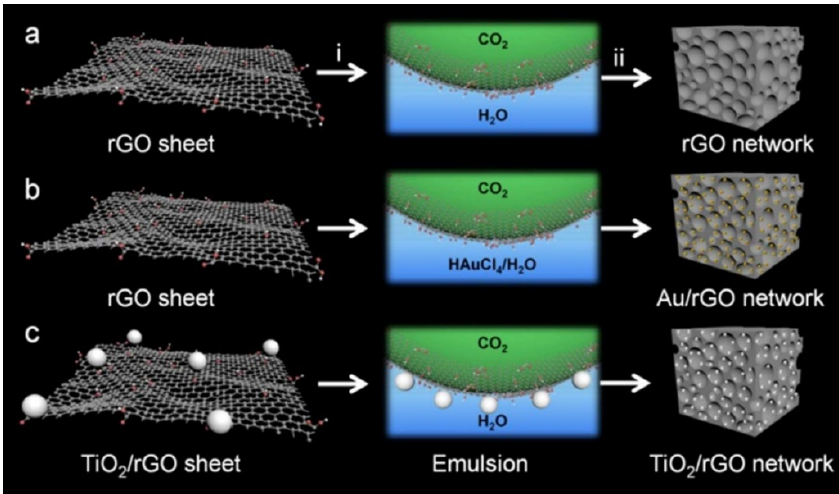
Figure 7. Schematic illustration for ( i ) forming emulsions in CO 2 and water with the aid of rGO or rGO hybrid and ( ii ) constructing rGO network ( a ), Au/rGO network ( b ) and TiO 2 /rGO network ( c ) by freeze depressurization and drying for emulsions. (Reproduced with permission from [112]. ACS Publications,